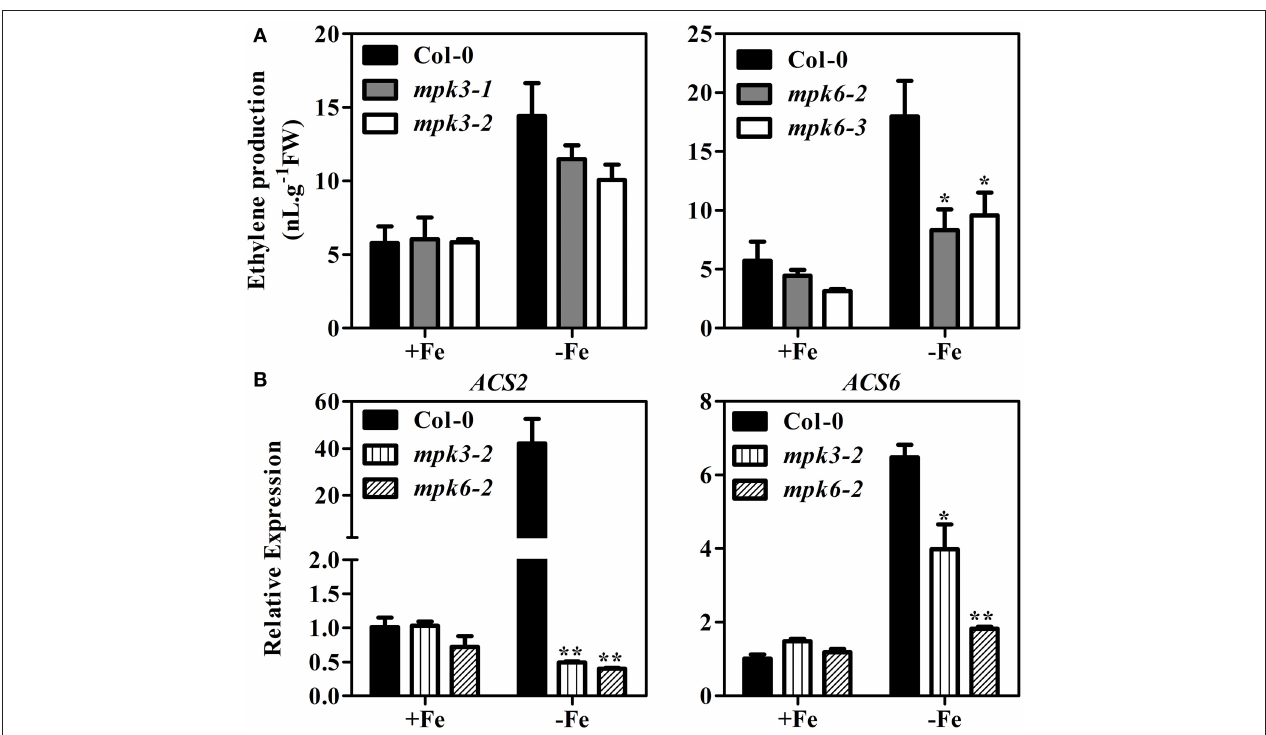
FIGURE 6 | Ethylene production and expression of ACS2 and ACS6 in mpk3 and mpk6 mutants. (A) Ethylene production in mpk3 and mpk6 mutants. (B) Transcript abundances of ACS2 and ACS6 genes in mpk3 and mpk6 mutants. Ten-day-old seedlings were transferred to Fe-sufficient (50 µ M EDTA-Fe) or -deficient (0 µ M EDTA-Fe) nutrient solutions. Ethylene accumulated over a 24h period from 10 seedlings in the headspace of GC vials was measured at 4 days after the treatment. qRT-PCR was conducted using RNA extracted from whole seedlings at 7 days after –Fe treatment. Data are shown as the mean ± SEM ( n = 3 ). Columns marked with “ * ” indicate a significant difference ( P < 0.05 ), and “ ** ” indicate a highly significantly difference ( P < 0.01